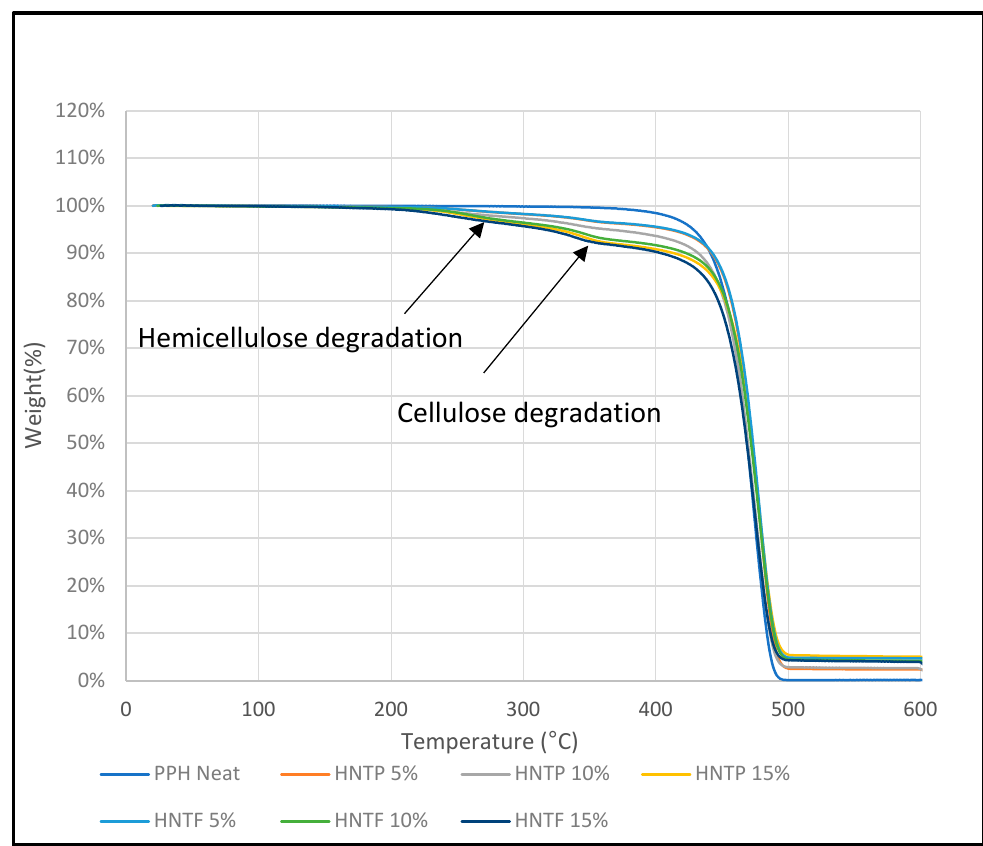
Figure 10. TGA of homo polypropylene-non-treated fiber composites.